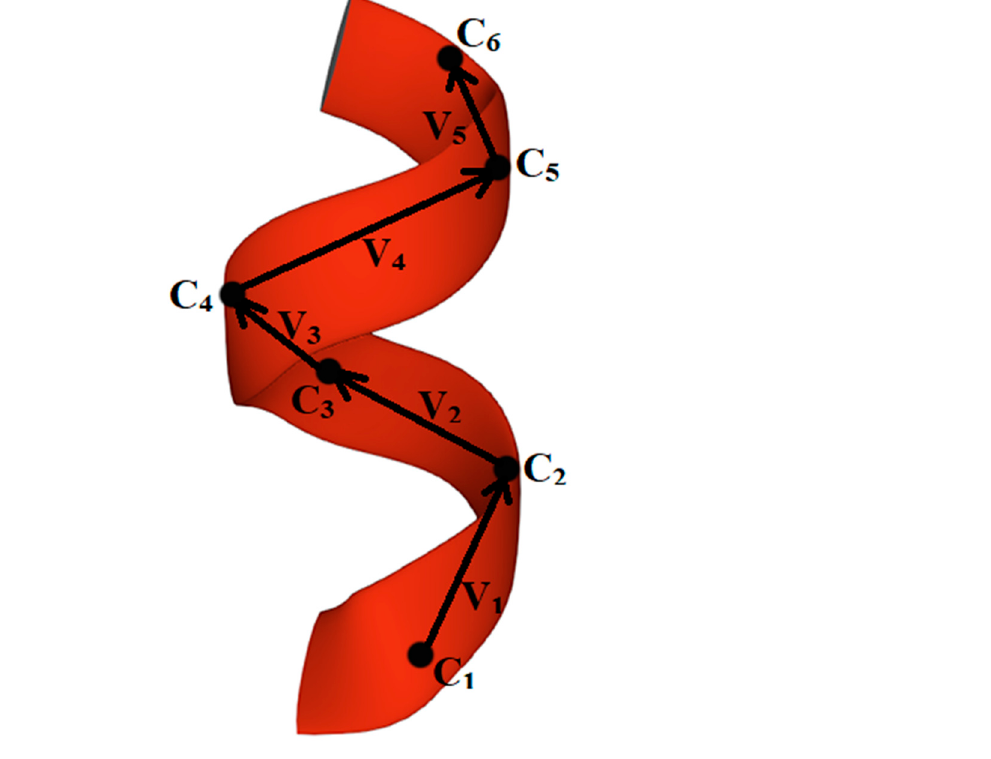
Figure 1. Graphic construction of vectors v i for calculating the mixed vector product of helical protein structure (1L63 [96], α -helix, residues 45–50). C i –atoms of α -carbons, reference points in helix.